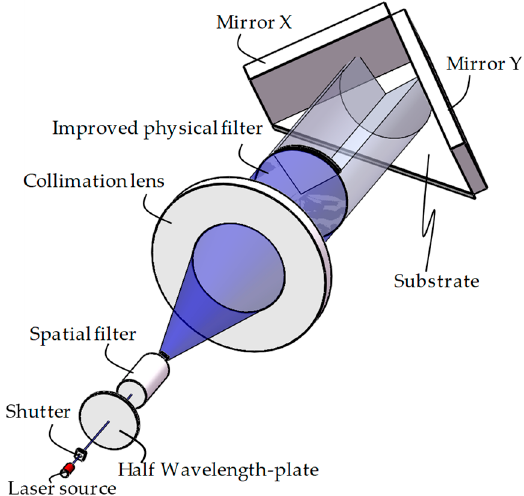
Figure 1. The optical configuration of the orthogonal type two-axis Lloyd’s mirror interferometer-based laser interference lithography (LIL) system.